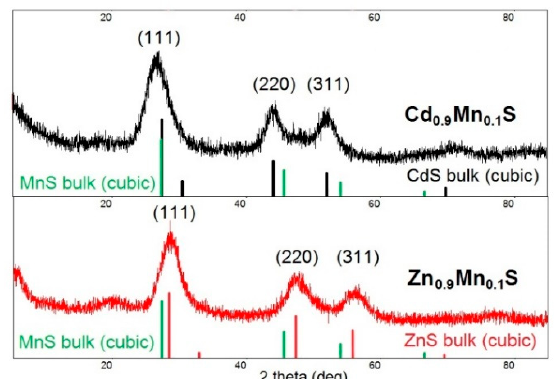
Figure 2. Diffraction patterns of Cd 0.9 Mn 0.1 S and Zn 0.9 Mn 0.1 S nanoparticles collected after 60 min of synthesis.